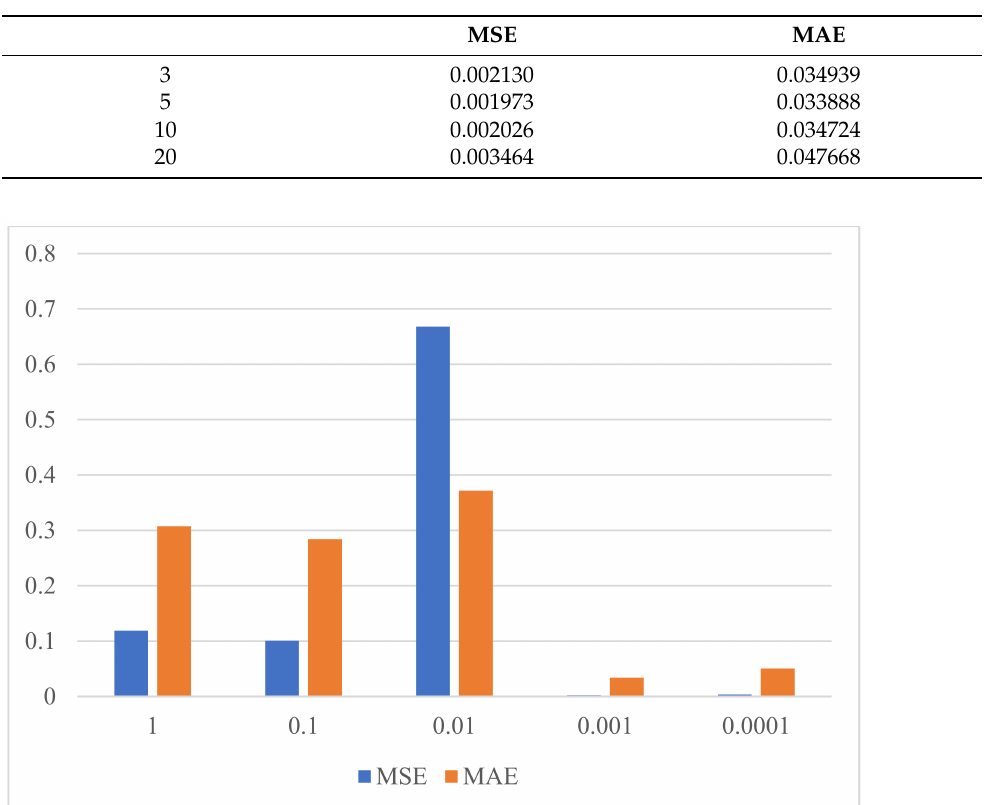
Table 2. Performance of the WT_TDLSTM model with different values of neurons in the hidden layers on the residential monthly electricity price dataset.